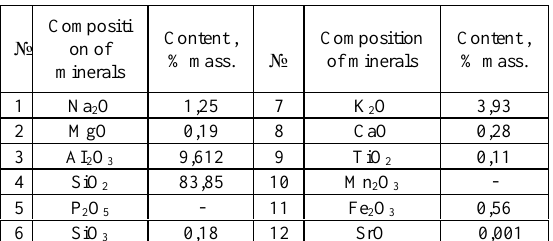
Table 3. Main technical characteristics of